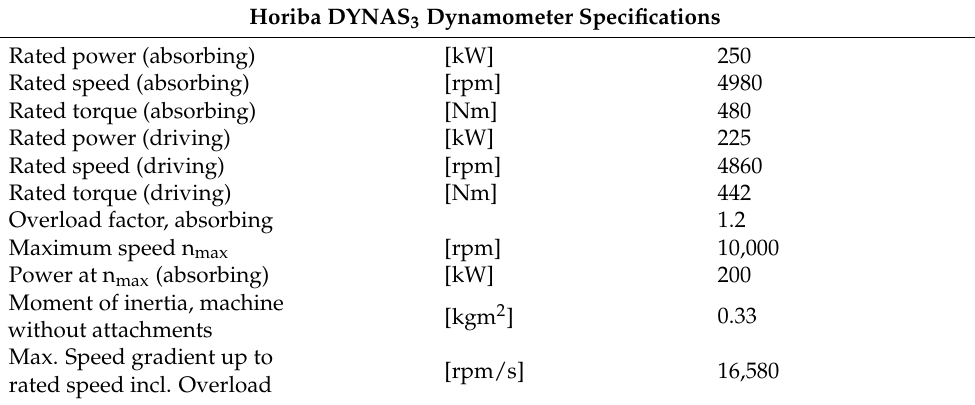
Table A3. Horiba Dynamometer Specifications (Source: